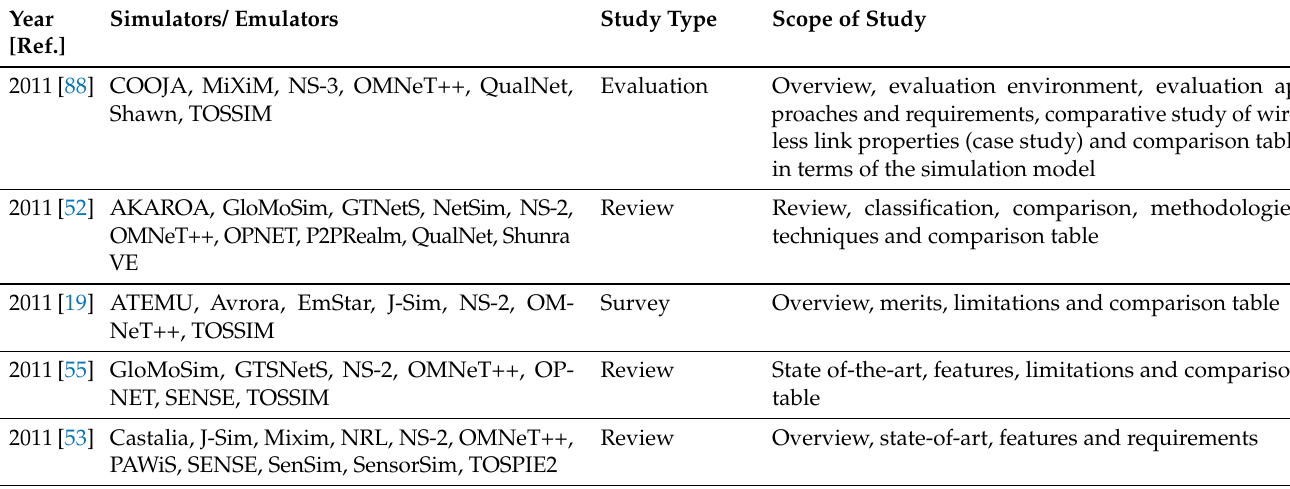
Table 1. Contribution of the Reviewed Studies (2011–2021).